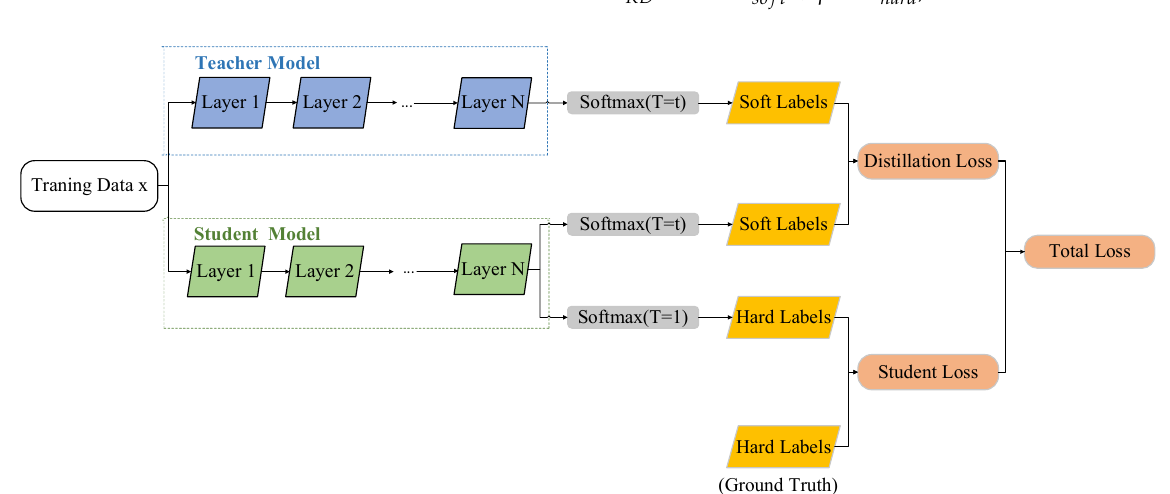
Figure 7. The schematic of knowledge distillation.